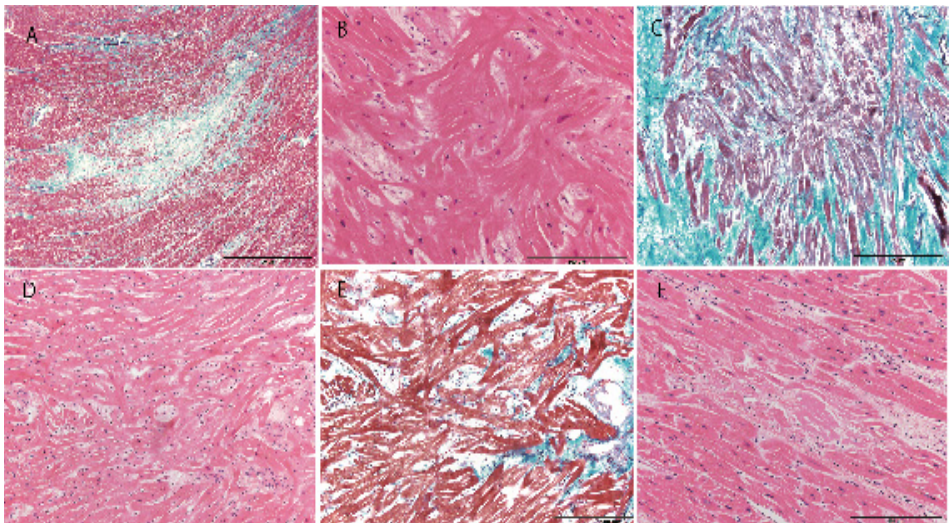
Figure 2. Histological appearance of the heart. A ; Myocardial scar in Case 1 (Masson–trichrome). B ; Myocyte disarray with hypertrophy of myocytes in Case 1 (hematoxylin–eosin). C ; Myocyte disarray with severe interstitial fibrosis in Case 2 (Masson–trichrome). D ; Myocyte disarray with mild myocyte hypertrophy in Case 7 (hematoxylin–eosin). E ; Myocyte disarray with mild interstitial fibrosis in Case 8 (hematoxylin–eosin). F ; Amyloidosis in Case 6 (hematoxylin–eosin). Scale bar = 2 mm (A), 200 µm (B-E).